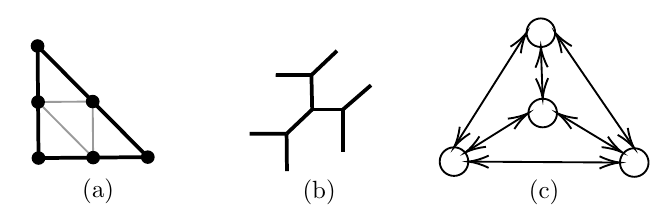
Figure 7 . (a) The toric diagram for C 3 / ( Z 2 × Z 2 ) . (b) Its dual web diagram. (c) The corresponding quiver (the Mercedes-Benz